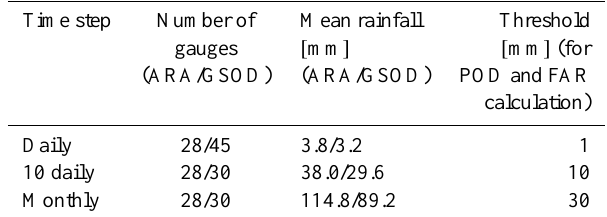
Table 2. Characteristics of the gauge data used for the pixel to point